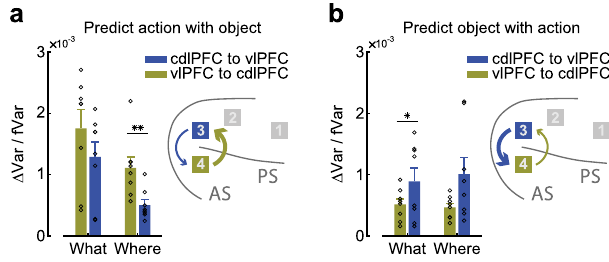
Fig. 7 Information fl ow between ventral and dorsal – caudal LPFC. Prediction variance between the cdlPFC and vlPFC. a Predicting action information with object information. b Predicting objects with action information. Inset: the location of each array and the fl ow direction and strength between them. Error bars represent mean ± SEM, n = 8 for each bar. A two-sided t test was used to compare two populations, * p = 0.0416, ** p = 0.0069. Source data are provided as a Source Data fi